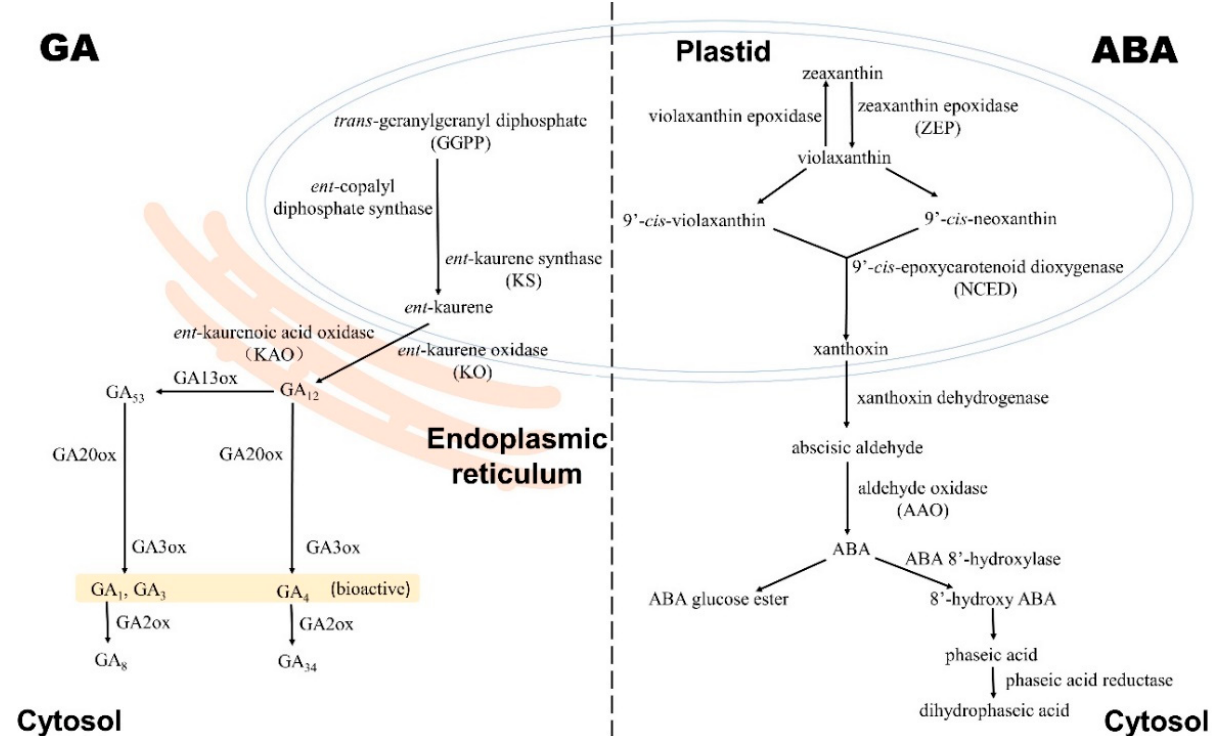
Figure 1. The major GA and ABA metabolism in tuber and root crops. The major GA and ABA metabolism (biosynthesis and catabolism) is predicated according to the expression patterns of genes for the key enzymes during stem/root tuber development and the detection of GA or ABA metabolites in stem/root tubers.